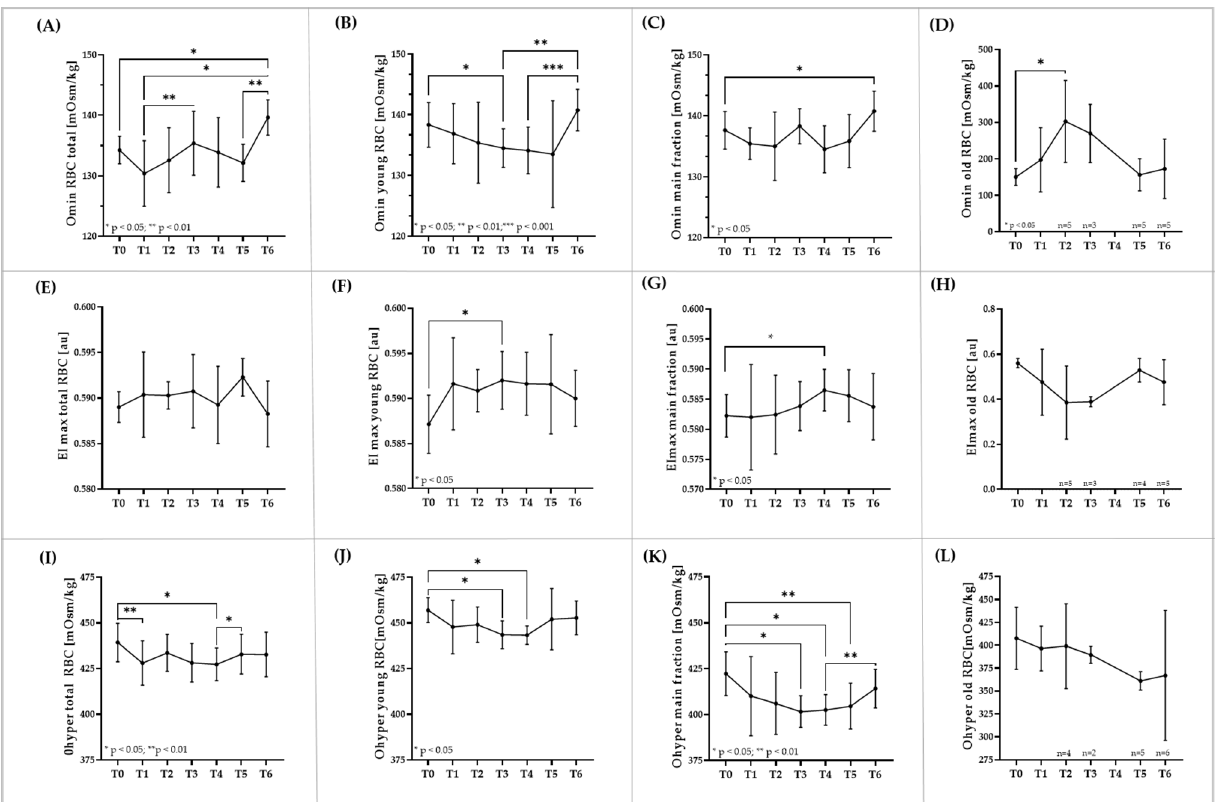
Figure 4. RBC deformability under an osmotic gradient during blood sampling and transfusion period. Omin ( A ) increased in the total RBC population during the study period, ( B ) while values decreased in young RBC, ( C ) increased in the main RBC fraction and ( D ) increased only during sampling period in old RBC. Maximum deformability EImax determined via osmoscan revealed ( E ) no changes in total RBC during blood sampling or post transfusion. Values increased in ( F ) young RBC and ( G ) main fraction and ( H ) reduced in old RBC during sampling period. Ohyper ( I ) of total RBC showed lower values during sampling while values increased during transfusion phase. Ohyper of ( J ) young RBC and ( K ) main fraction decreased during sampling but increased during transfusion phase. Ohyper of ( L ) old RBC decreased throughout the study period. Data are mean (SD).